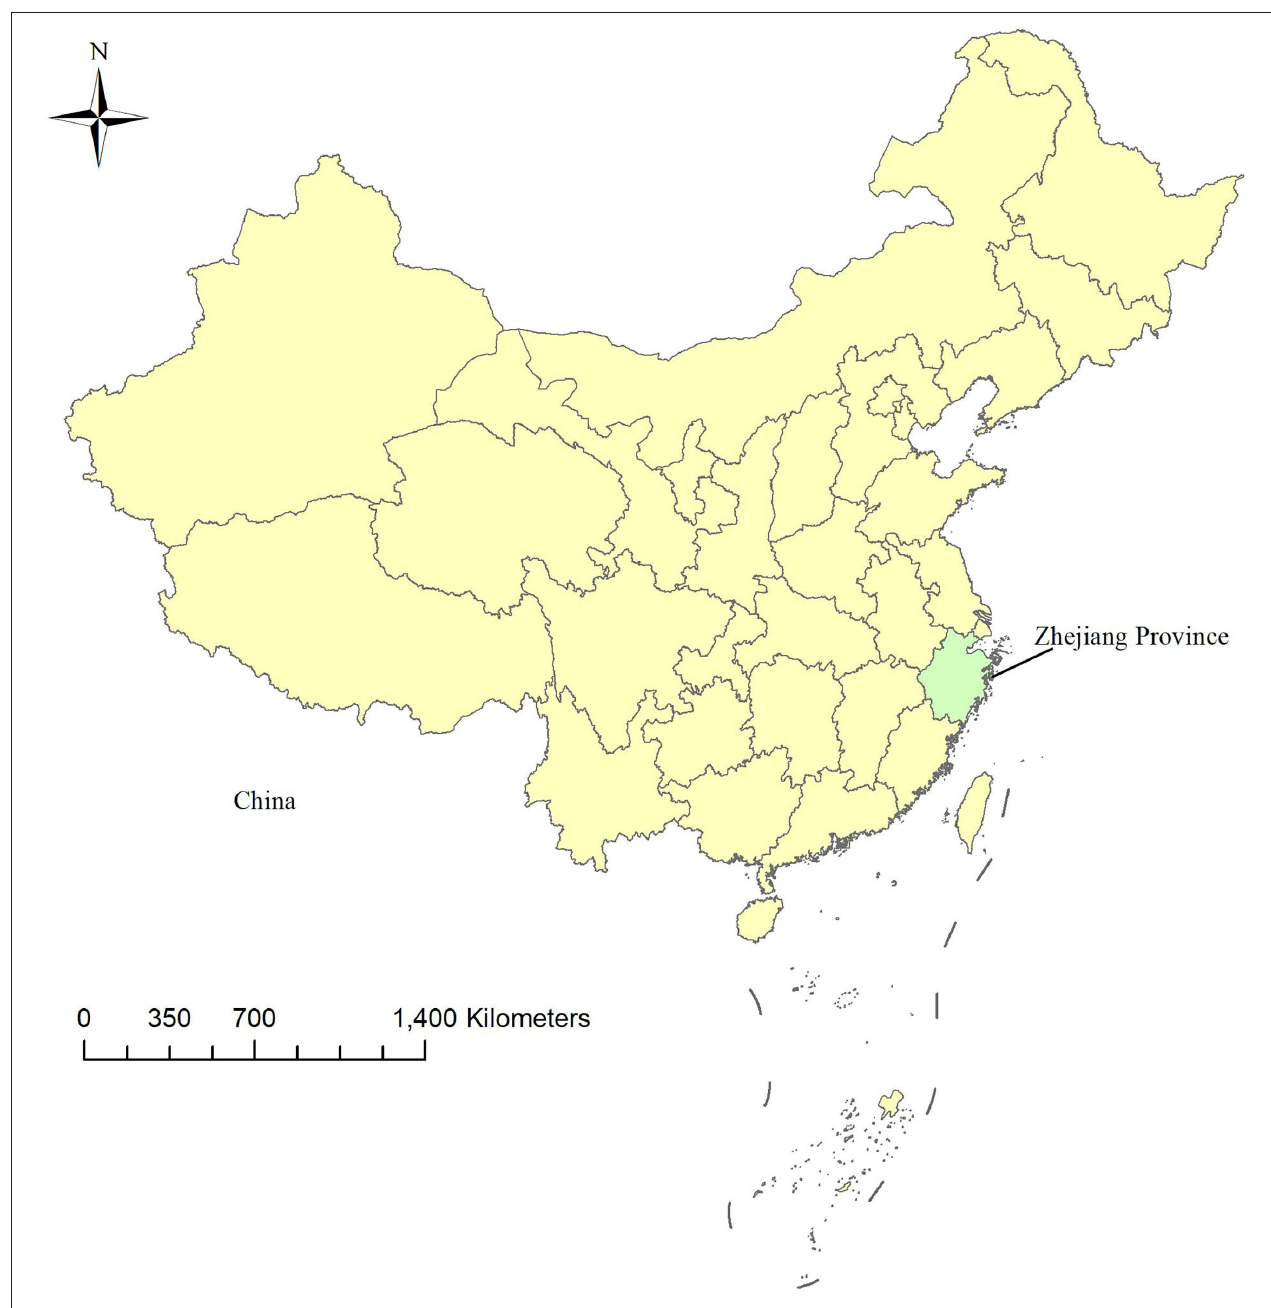
FIGURE 1 | Location of Zhejiang province in